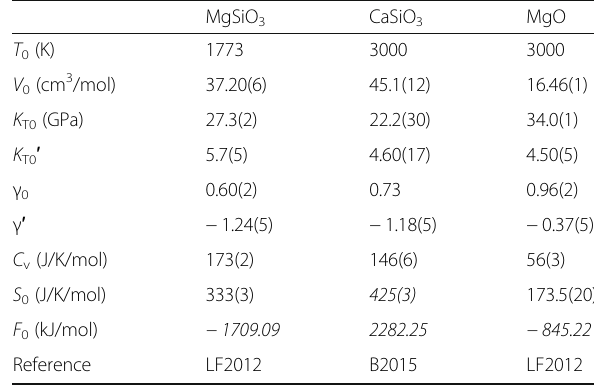
Table 3 Thermodynamic properties of liquids